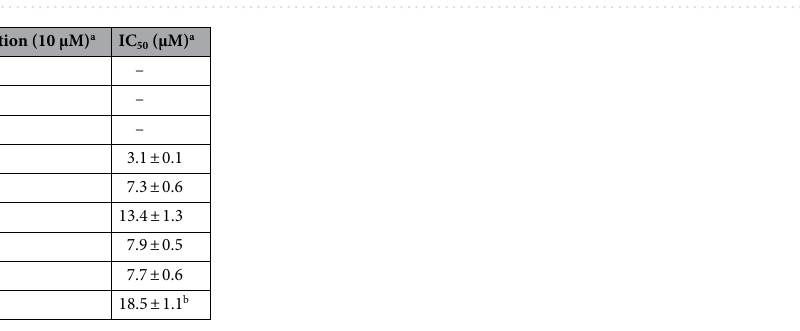
Figure 7. ( a ) TLC of the fractionated starting extract of C. zedoaria (CZ1). ( b ) TLC of the fractionated engineered mixture. Both TLCs were developed with CHCl 3 /ethyl acetate (19:6) and then visualized by staining with an acidic solution of p -anisaldehyde. The upper dashed line indicates the solvent front. ( c ) Structures of the hybridized Ugi adducts 11 – 13 .